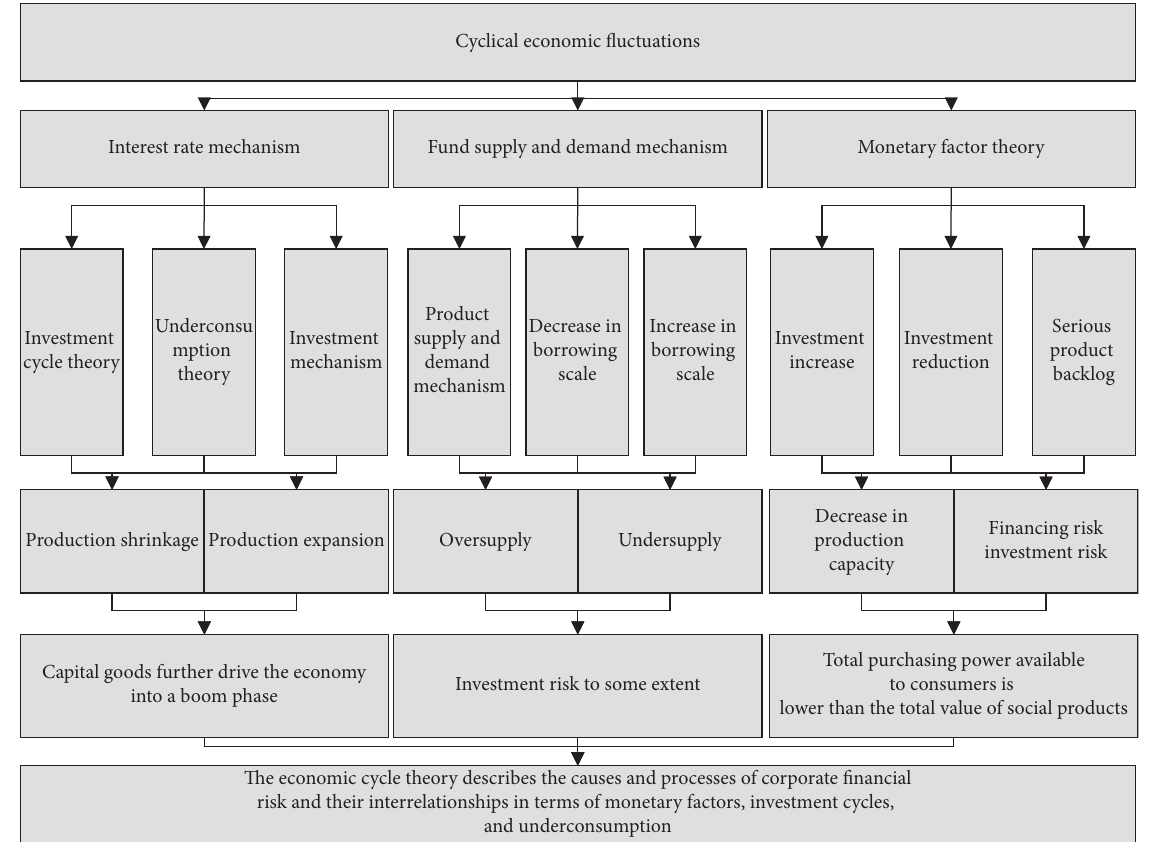
Figure 1: Relationship between economic cycle theory and financial risk